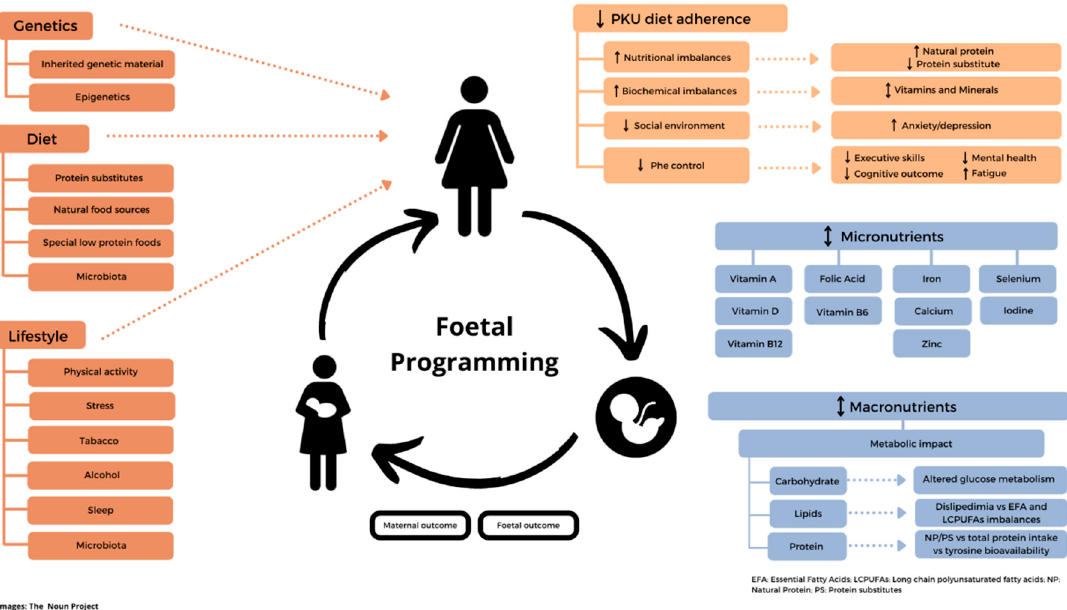
Figure 1. Preconception environmental and nutritional factors that may affect the foetal outcome in Figure 2. Foetal metabolic programming in women with PKU: influence of genetics, dietary man-